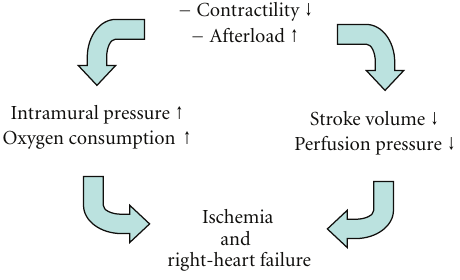
Figure 5: Mechanisms of acute right-heart failure.